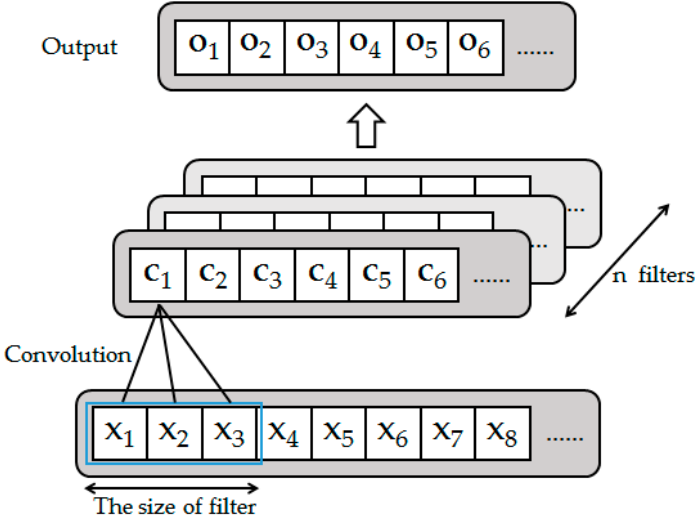
Figure 3. The architecture of the convolution operation.